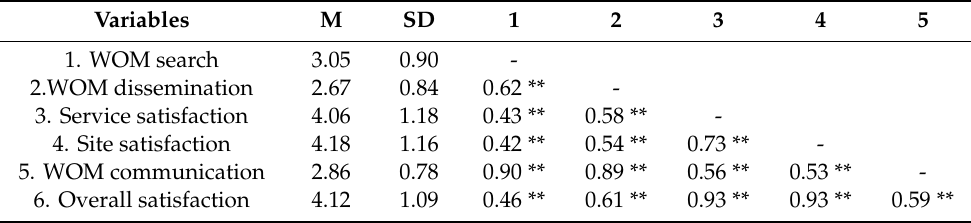
Table 8. Descriptive statistics, reliabilities and correlations of the